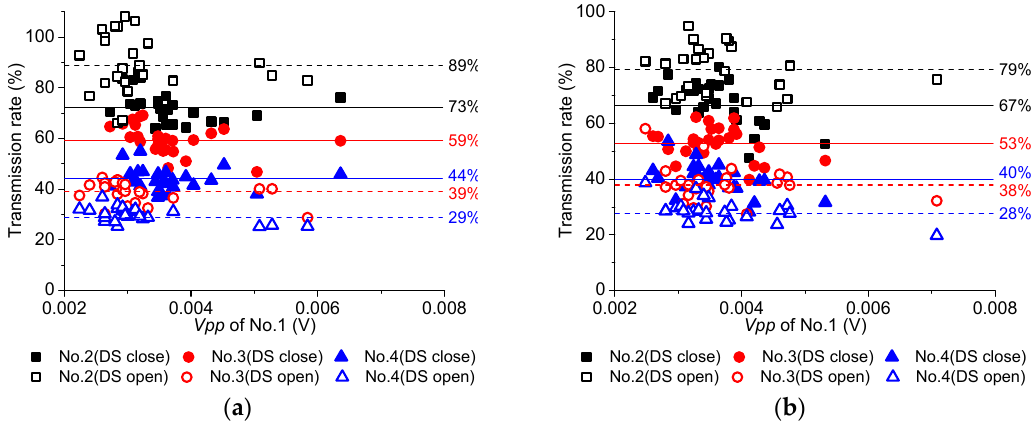
Figure 10. The transmission rates of UHF signals at θ = 90°. ( a ) U = 10 kV; ( b ) U = 14.5 kV.